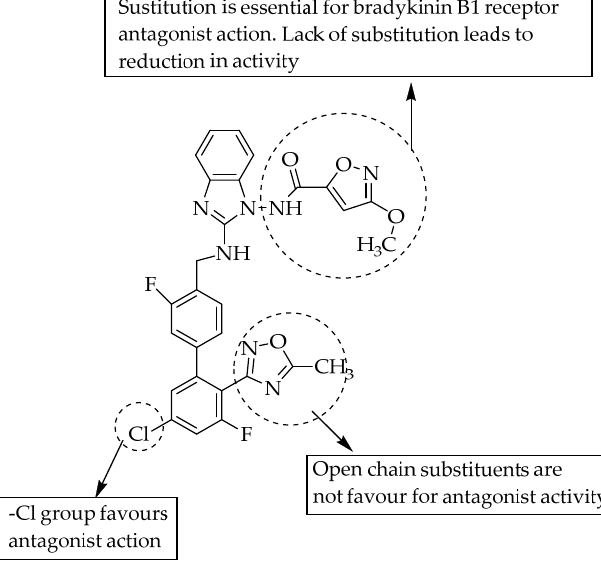
Figure 11. SARs of 2-aminobenzimidazole as bradykinin B1 receptor